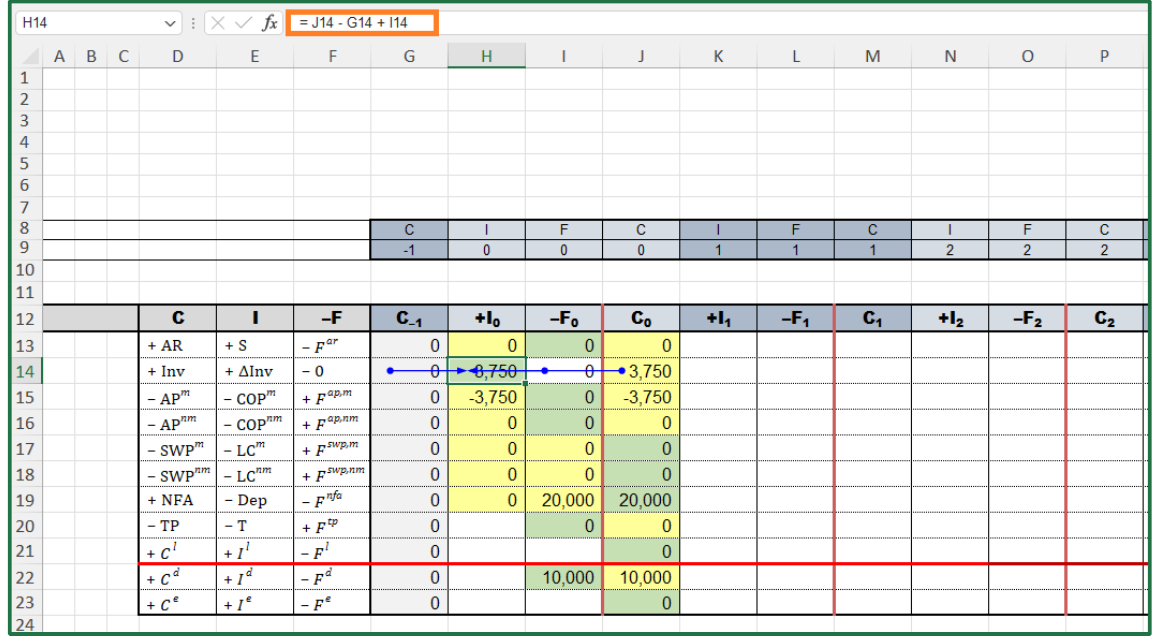
Figure 14. Cell H14 contains the law of motion for ∆ Inv 0 (“SplitScreenStrip” sheet). (The cells whose values are provided in “PreCalc” are in yellow and the cells whose values are calculated with the law of motion are in green.)